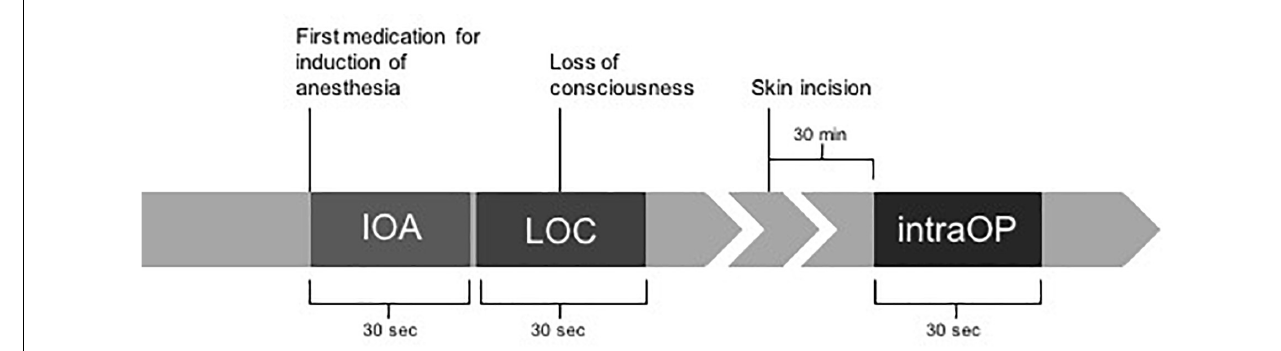
FIGURE 1 | Timeline of chosen EEG segments during perioperative EEGs. A total of 30-second EEG segments were selected for further analyses based on different marked time points during anesthesia induction and surgery. Markers comprised administration of the first drug for induction of anesthesia (IOA), loss of consciousness marked by the loss of eye-lid reflex (LOC), and a stable phase during anesthesia 30 min after the beginning of surgery marked by incision of the skin (intraOP).